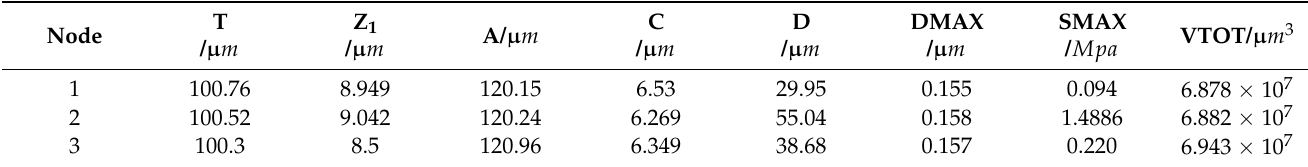
Table 3. Pareto optimal set of multi-objective